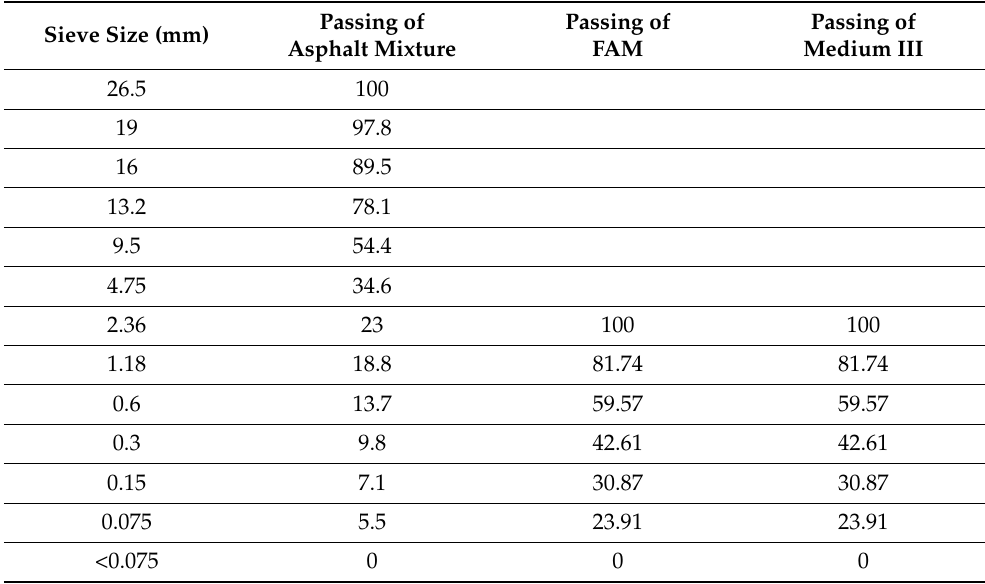
Table 7. The grading of the asphalt mixture, FAM, and medium III. Sieve Size (mm)